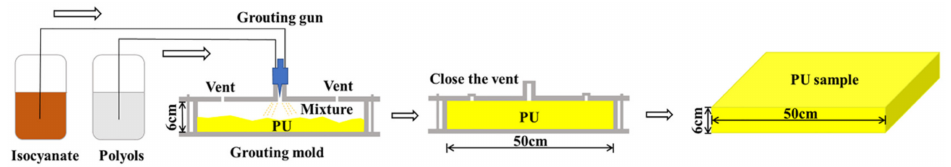
Figure 7. The preparation process of the PU